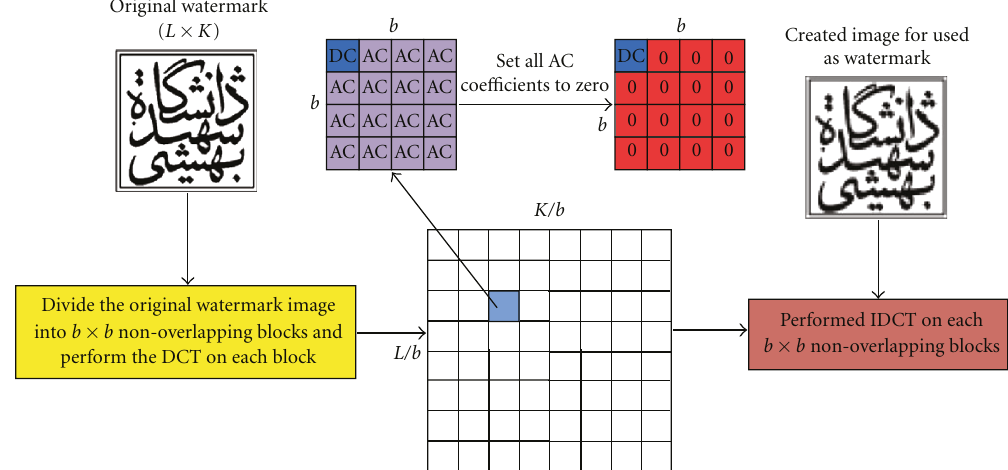
Figure 7: The watermark creation procedure.